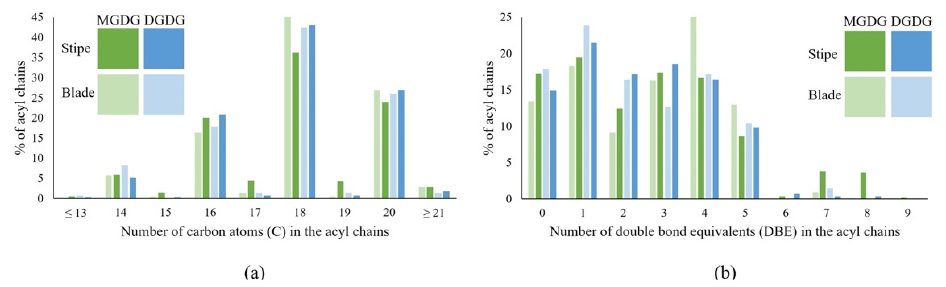
Figure 3. Distribution of ( a ) the number of carbon atoms (C), and ( b ) the double bond equivalents (DBE) in the acyl chains of mono- and digalactosyldiacylglycerols (MGDG and DGDG, respectively) for blade and stipe from Laminaria hyperborea . Note that this figure represents the number of identified acyl chains with a given C or DBE, not the quantity of the lipids.